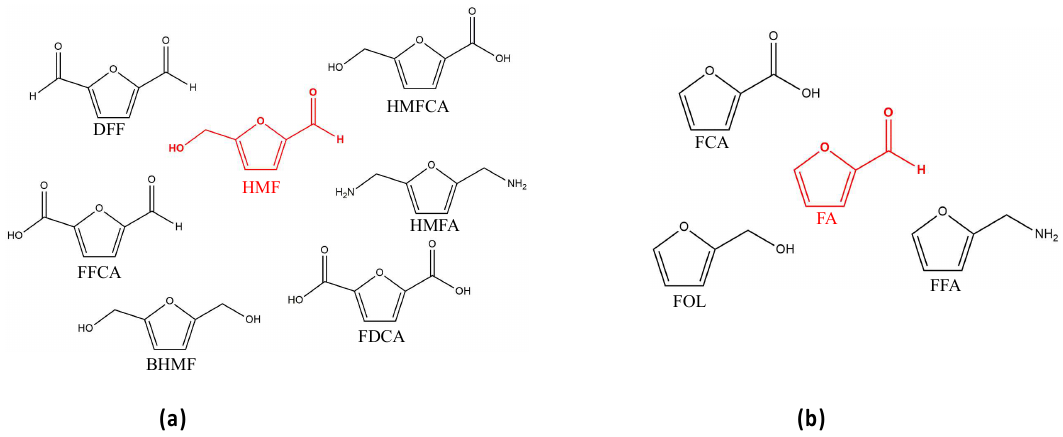
Figure 2. Overview of different monomers originating from ( a ) HMF and ( b ) FA. HMF : 5- hydroxymethylfurfural, DFF : furan-2,5-dicarbaldehyde, HMFCA : 5-hydroxymethyl-2-furancarboxylic acid, FFCA : 2,5-formylfurancarboxylic acid, FDCA : 2,5-furandicarboxylic acid, HMFA : 5- (hydroxymethyl)furfurylamine, FA : furfural, 2-furaldehyde, BHMF : 2,5-bis(hydroxymethyl)furan, FCA : 2-furancarboxylic acid or furoic acid, FFA : 2-furfurylamine, FOL : 2- (hydroxymethyl)furan.